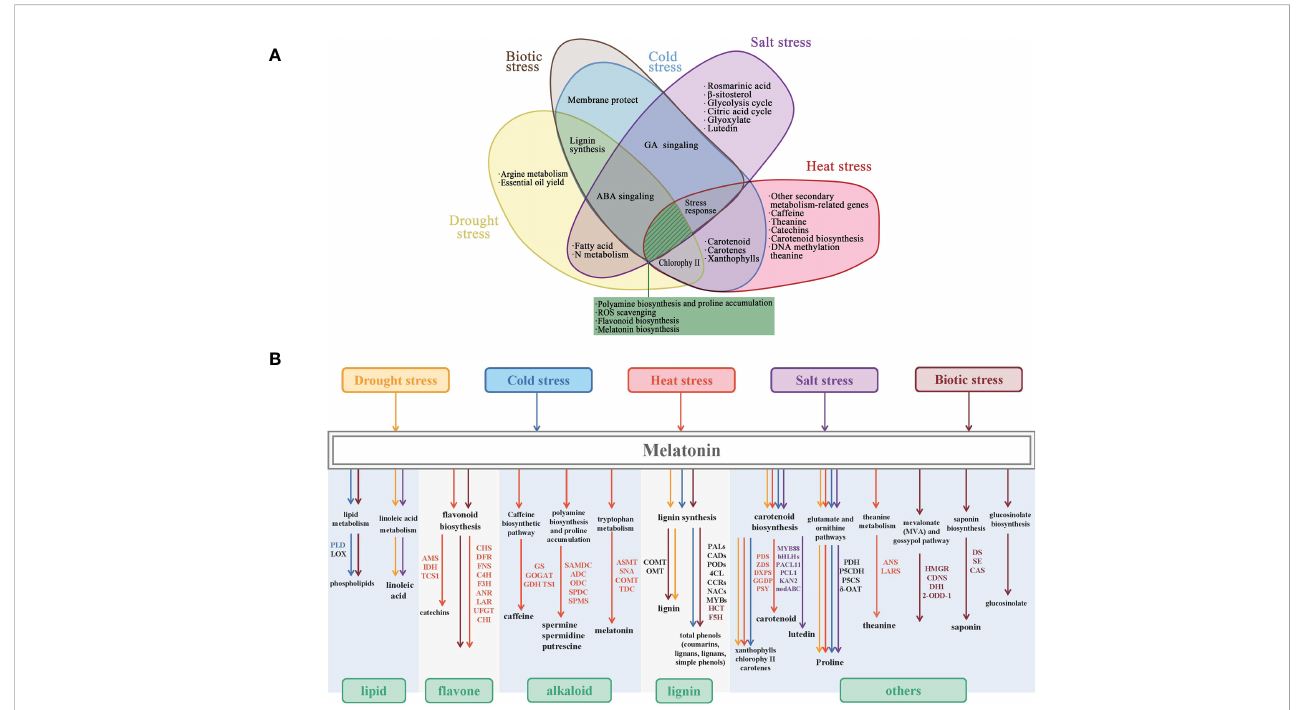
FIGURE 2 Synthesis and metabolism patterns of melatonin-induced secondary metabolites in response to stress. (A) Melatonin modulates various mechanisms against abiotic stresses (salt, cold, heat, and drought). (B) Melatonin induces common changes in gene expression in secondary metabolic pathways. PLD, phospholipase D; TCS1, tea caffeine synthase 1; CHS, chalcone synthase; DFR, dihydro fl avonol 4-reductase; TIDH, inosine 5 ′ -monophosphate dehydrogenase; LOX, lipoxygenase; AMS, S-adenosyl-l-methio-nine synthase; FNS, fl avone synthase; C4H, cinnamic acid 4-hydroxylase; F3H, fl avanone 3-hydroxylase; ANR, anthocyanidin reductase; LAR, leucoanthocyanidin 4-reductase; UFGT, UDP-glucose: fl avonoid 3-O-glucosyltransferase; CHI, chalcone isomerase; GR, glutathione reductase; GSH, glutathione; GSNOR, S-nitrosoglutathione reductase; TS1, theanine synthase; ASMT, acetylserotonin O-methyltransferase; SNAT, serotonin N-acetyltransferase; COMT, caffeoyl-O-methyltransferase; TDC, tryptophan decarboxylase; OMT1, fl avone 3 ′ -O-methyltransferase 1; PAL, phenylalanine ammonia-lyase; CAD, cinnamyl alcohol dehydrogenase; POD, peroxidase; 4CL, 4-coumarate-CoA ligase; CCR, cinnamoyl CoA reductase; NACs, IAA-related factors; MYBs, regulator of CBF; PDS, phytoene desaturase; ZDS, z -carotene desaturase; bHLHs, basic helix – loop – helix; PCL1, phenylalanine ammonia lyase 1; PDH, pyruvate dehydrogenase; P5CDH, delta-1-pyrroline-5-carboxylate dehydrogenase; P5CS, pyrroline-5-carboxylate synthetase; OAT, ornithine aminotransferase; F5H, ferulic acid 5-hydroxylase; HCT, hydroxycinnamoyl transferase; HMGR, HMG-CoA reductase; CDNS, (+)-d-cadinene synthase; DH1, alcohol dehydrogenase; 2-ODD-1, 2-oxoglutarate/Fe(II)-dependent dioxygenase; DS, dammarene diol-II synthase; SE, squalene epoxidase; CAS, cyclohexene